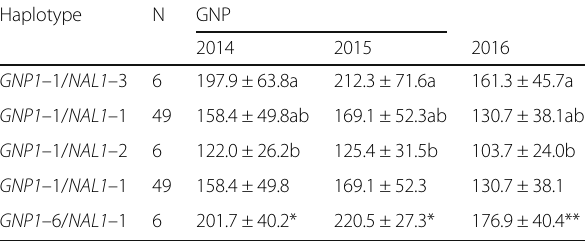
Table 2 Comparison of grain number among genotype combinations at NAL1 and GNP1 in xian subpopulation Haplotype